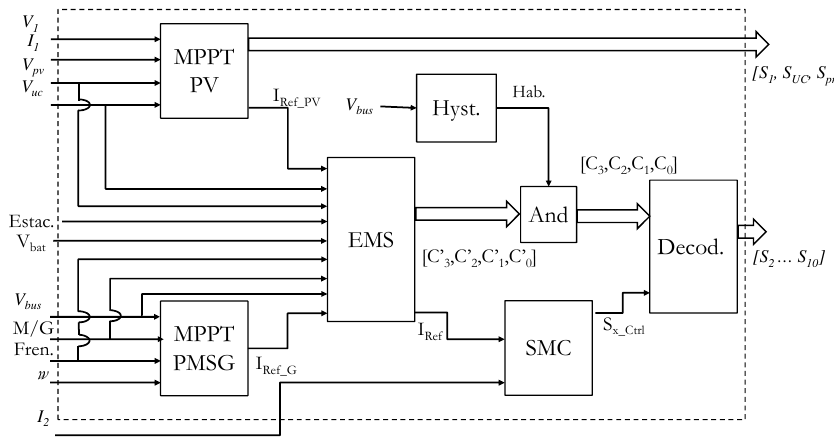
Figure 10. Block diagram of the controller of the system. Table 5. Demonstration of the homogeneity of the control parameter for the regulation of the current with SMC in a buck and a boost